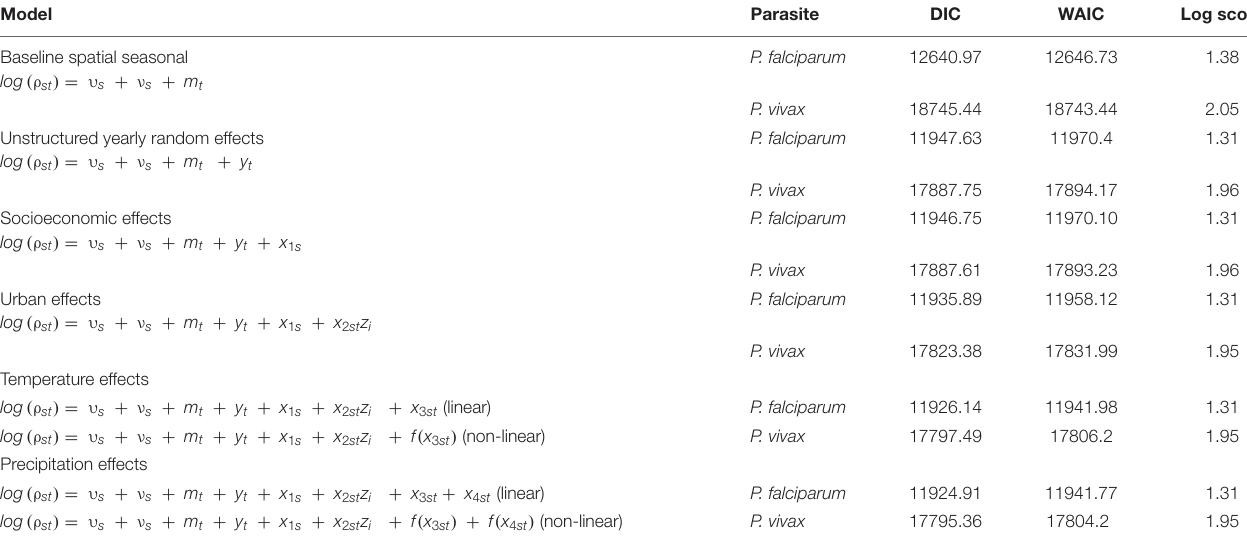
FIGURE 2 | Parameter estimates for explanatory variables of P. falciparum and P. vivax malaria in El Oro 1990–2018. (A) Posterior mean and 95% credible intervals for minimum temperature and precipitation, included as linear terms, level of urbanization and poverty covariates for P. falciparum (pink) and P. vivax (blue) malaria. (B) Relationships between P. falciparum and P. vivax relative risk, on the log scale defined as the annual parasite incidence (API), log( ρ st ), and minimum temperature, lagged by 3 months, included in the model as a function to allow for non-linearities. TABLE 1 | Adequacy results, deviance information criterion (DIC), Watanabe–Akaike Information Criterion (WAIC) and cross-validated log score for full models of P. falciparum and P. vivax malaria in El Oro 1990–2018.